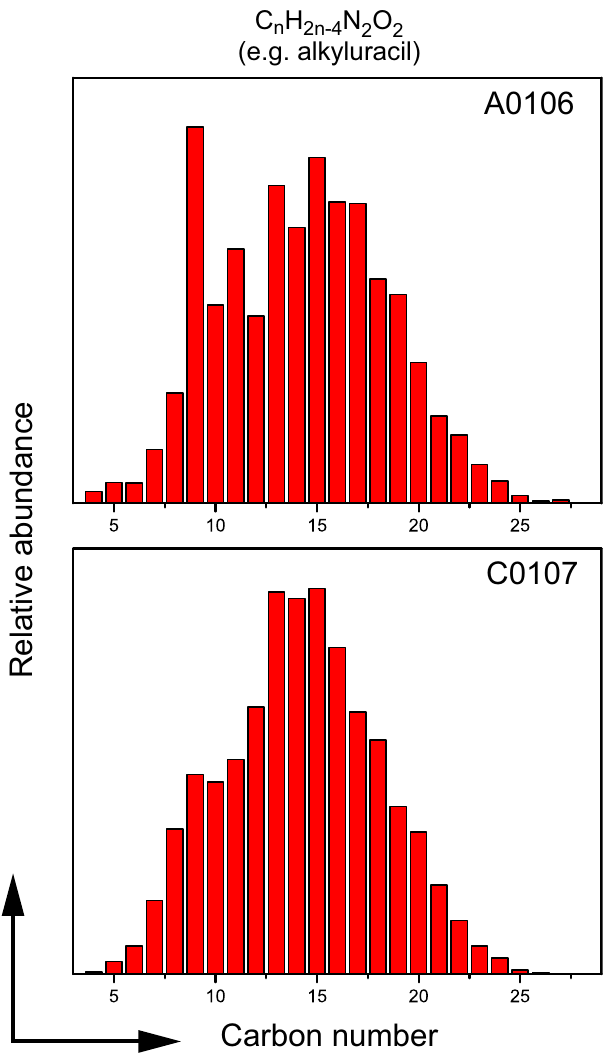
Fig. 7 | Detection of CHNO molecules in the methanol extract from the Ryugu samples. Relative peak area of alkylated analogs of CHNO molecules having a generalformulaofC n H 2n-4 N 2 O 2 whichincludeuracilandtheirstructuralisomersin the methanol extracts from the A0106 (top) and C0107 (bottom) samples with relevance to the number of carbon atoms ( n =5 – 30) in a molecule. The horizontal axisshows the number of carbon atoms and the vertical axis shows the sum ofthe peak area at each m/z in arbitrary